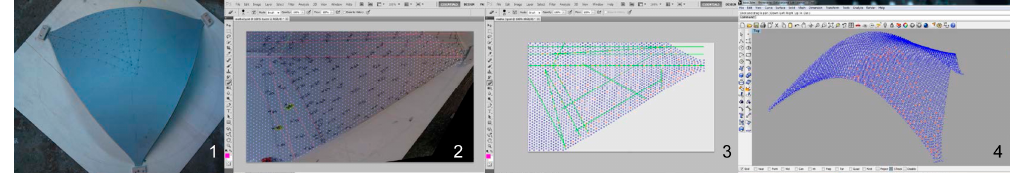
Figure 10. Points for location of pressure sensors: ( 1 ) marking points on the scale model; ( 2 ) image superimposed to the virtual points cloud; ( 3 ) marking points on the virtual model; ( 4 ) sub-cloud of points—red points.